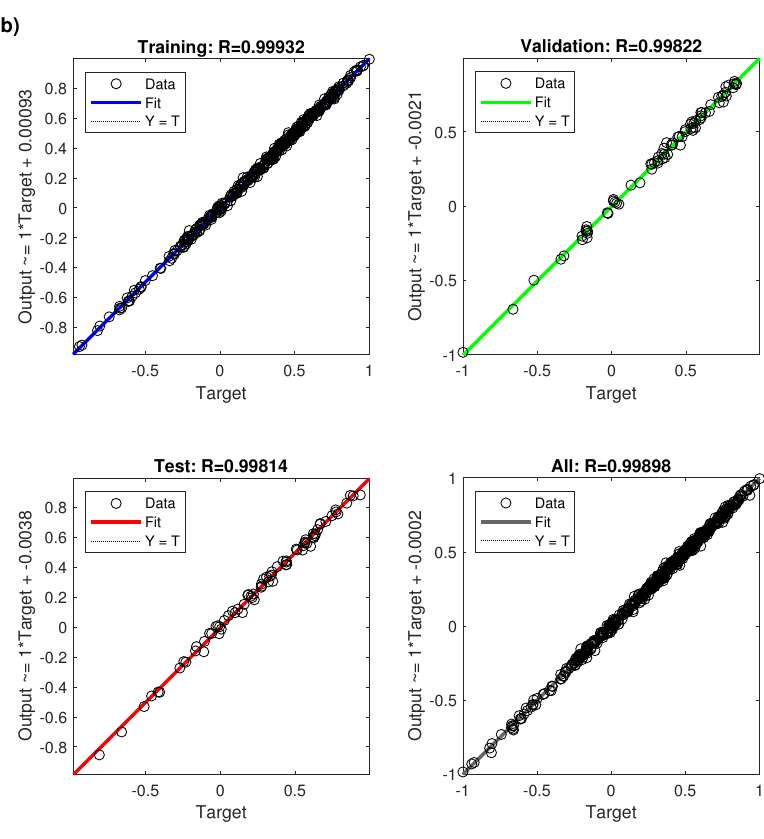
Figure 11. The crossplot results between true values and surrogate-based values based on the training samples, validation samples and testing samples. The MLP surrogate models are trained by ( a ) 100 samples and ( b ) 500 samples, respectively.